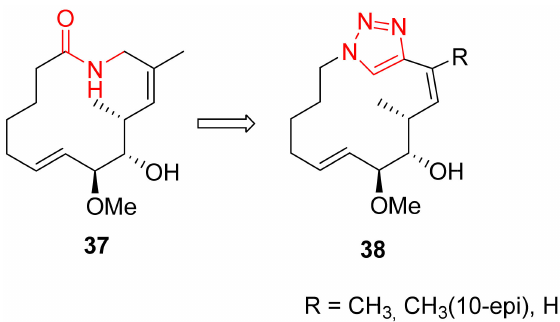
Figure 17. Structures of the migrastatin analogue 37 and triazole-migrastatine 38 .